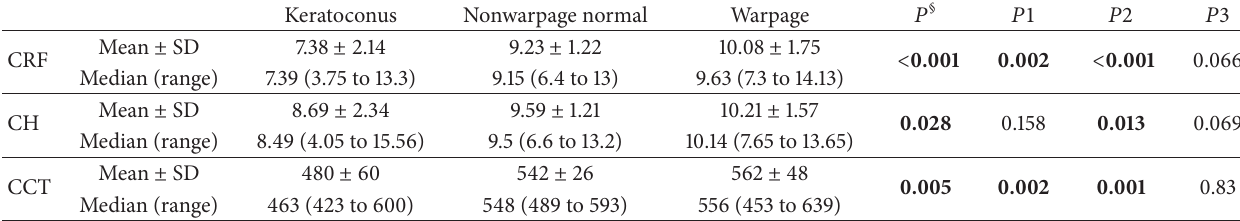
Table 3: Corneal biomechanical indexes according to the final